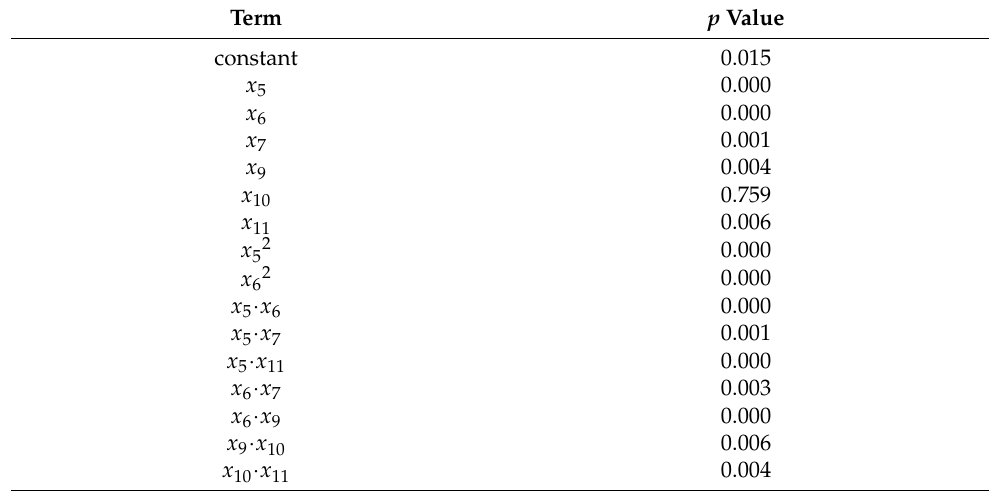
Table 7. ANOVA of indentation depth prediction